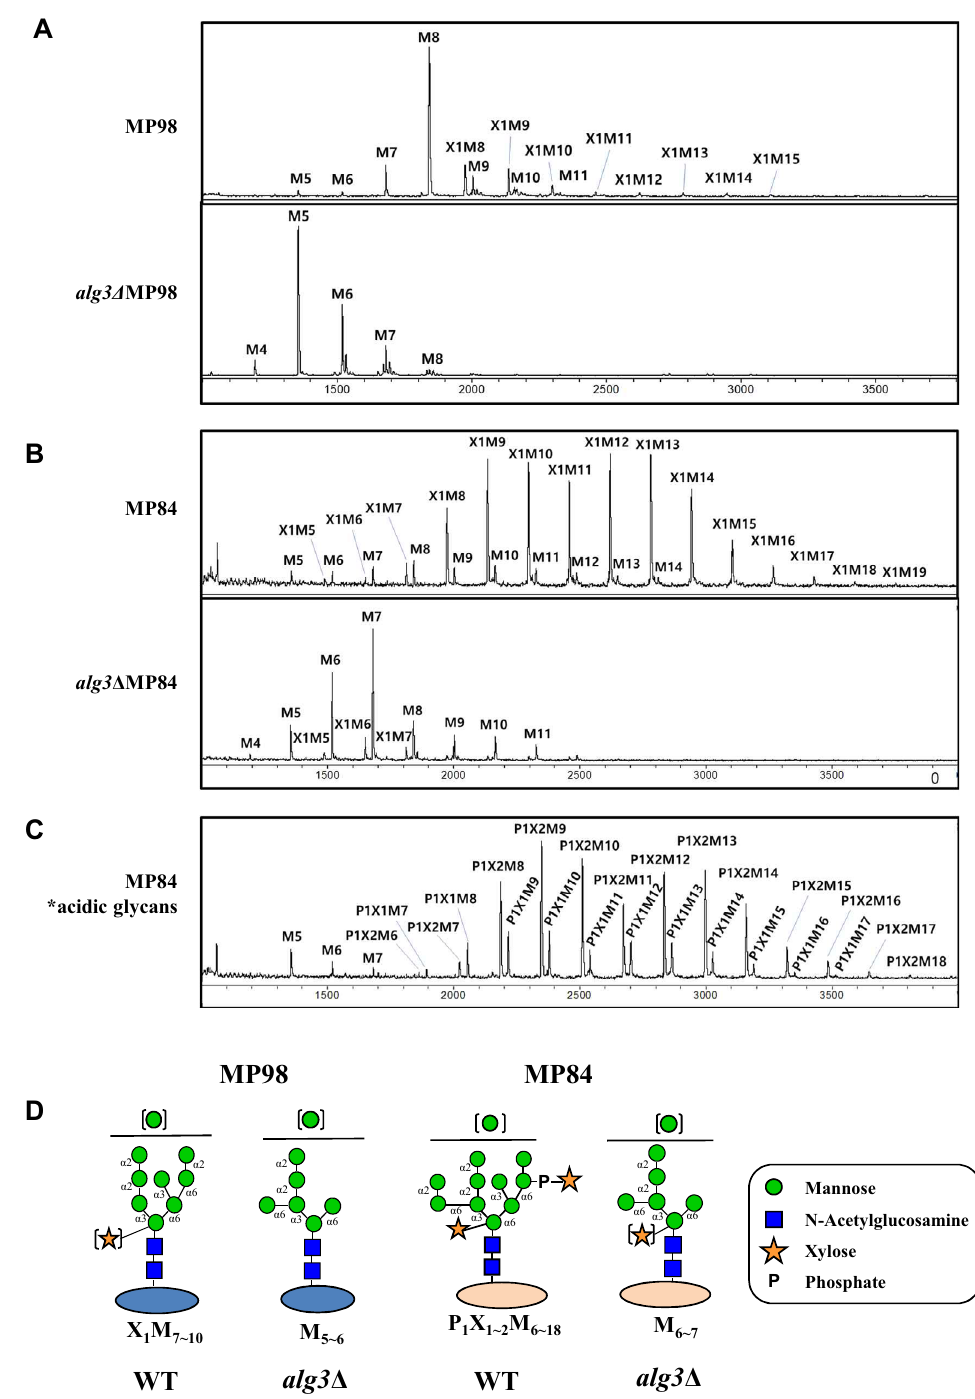
Figure 2. MALDI-TOF profiles of N -glycans assembled on MP98 and MP84. ( A ) Analysis of neutral N -glycans assembled on MP98 expressed in C. neoformans WT and alg3 Δ mutant strains. ( B ) Neutral N -glycans assembled on MP84 expressed in WT and alg3 Δ strains. ( C ) Acidic N -glycans assembled on MP84 expressed in C. neoformans WT. ( D ) Structures of N -glycans assembled on MP98 and MP84 secreted from WT and alg3 Δ. P n X n M n represents Pho n Xyl n Man n GlcNAc 2 glycans (n = number of phosphates, xyloses, and